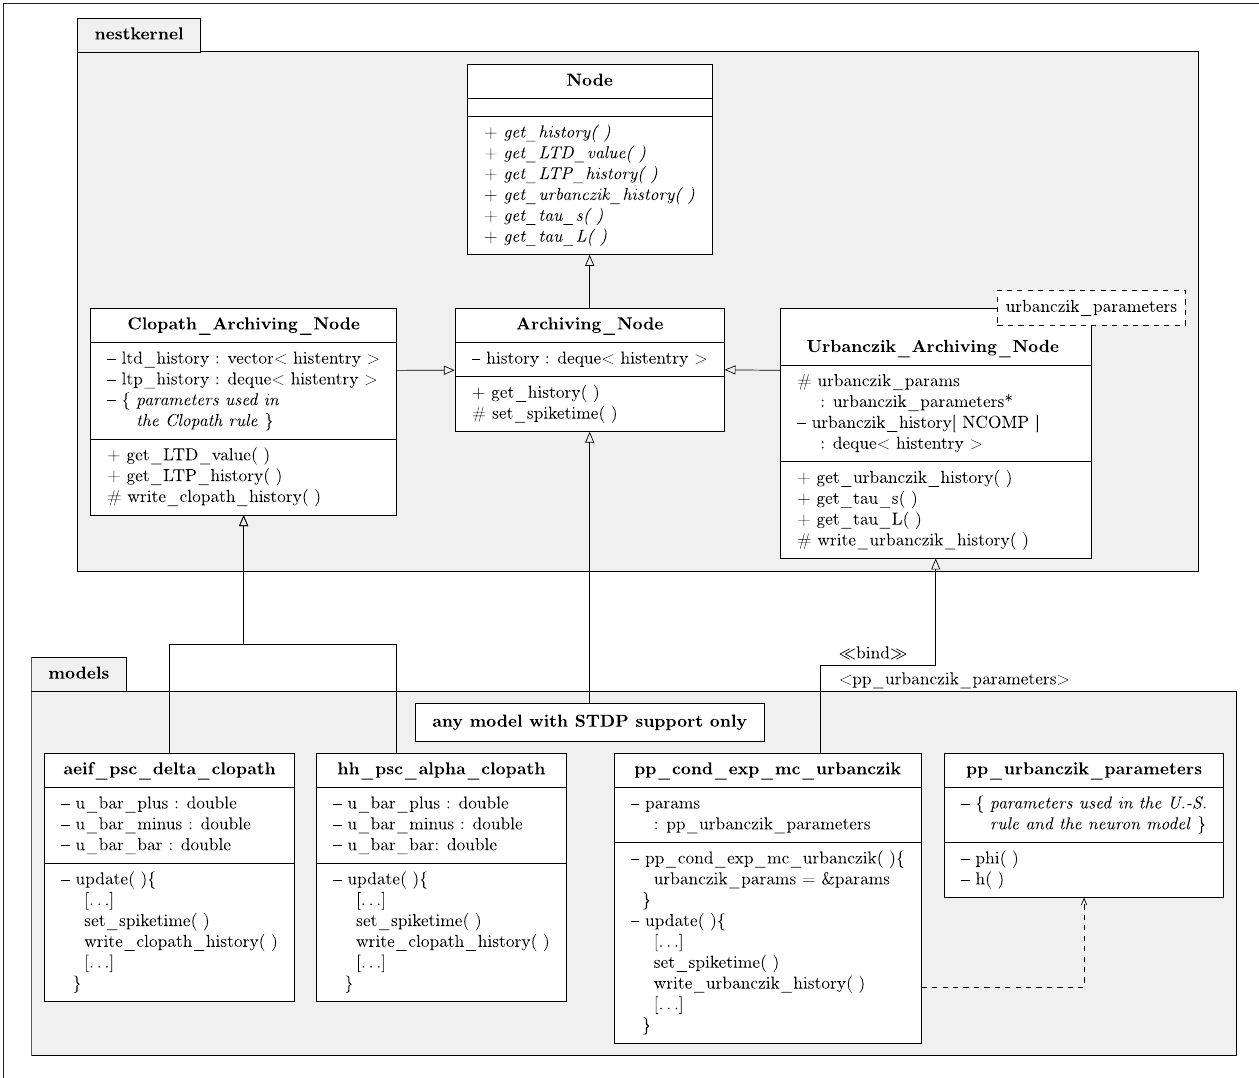
FIGURE 6 | Class diagram of NEST classes and functions. Simplified class diagram for embedding the Clopath (Left) and Urbanczik-Senn rule (Right) in the NEST infrastructure. The code is distributed across the nestkernel and neuron models. nestkernel contains the base class Node of all neurons models. Models that support ordinary STDP are derived from the Archiving_Node , models that can use the Clopath synapse ( aeif_psc_delta_clopath and hh_psc_alpha_clopath ) or Urbanczik-Senn synapse ( pp_cond_exp_mc_urbanczik ) are derived from the Clopath_Archiving_Node or the Urbanczik_Archiving_Node , respectively. The latter add the required functions for storing and managing the history of continuous quantities. The model pp_cond_exp_mc_urbanczik requires a helping class pp_urbanczik_parameters because the Urbanczik_Archiving_Node needs to access